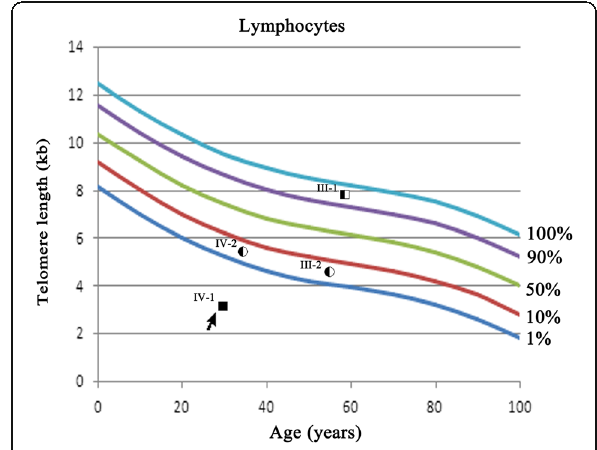
Fig. 3 Measurement of telomere length by flow-FISH in the peripheral blood lymphocytes. Absolute telomere lengths in kb of the lymphocytes of the proband (IV-1), his sibling (III-2) and his parents (III-1 and III-2) are shown in the context of the age-dependent